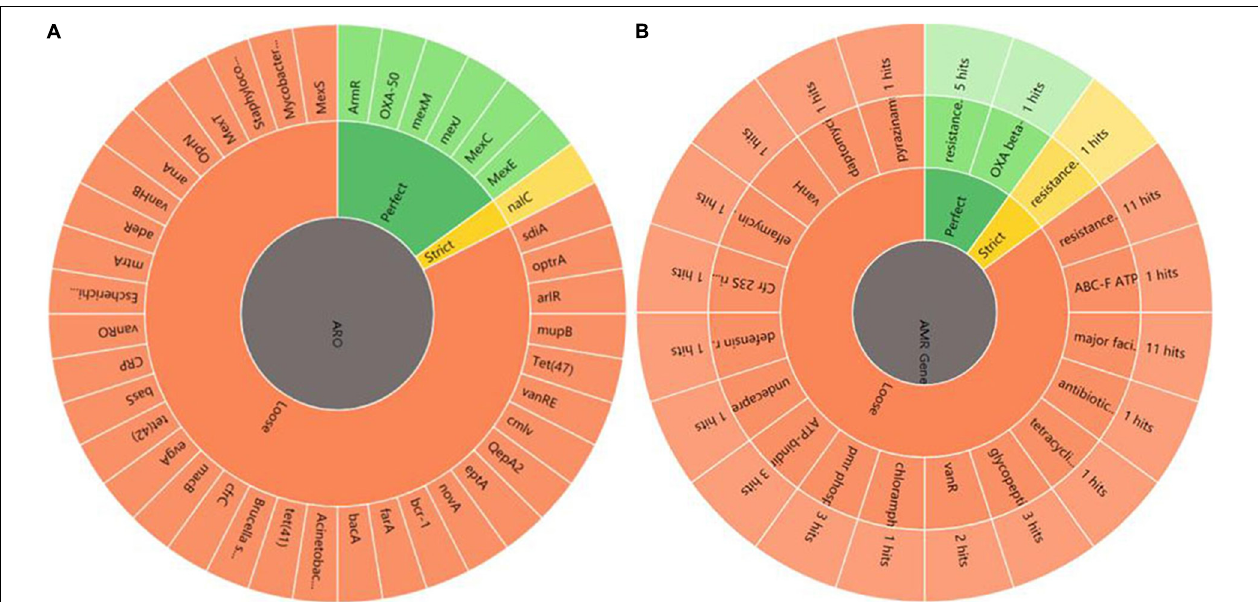
FIGURE 5 | Annotation and analysis of co-expressed resistant genes between HL. (A) AMR genes. ARO represents antibiotic resistance ontology. The outer ring represents antibiotic resistance genes in the figure. (B) AMR gene family. The inner ring represents the anti-microbial resistance (AMR) gene families and the outer ring represents hits the numbers of resistance genes predicted.